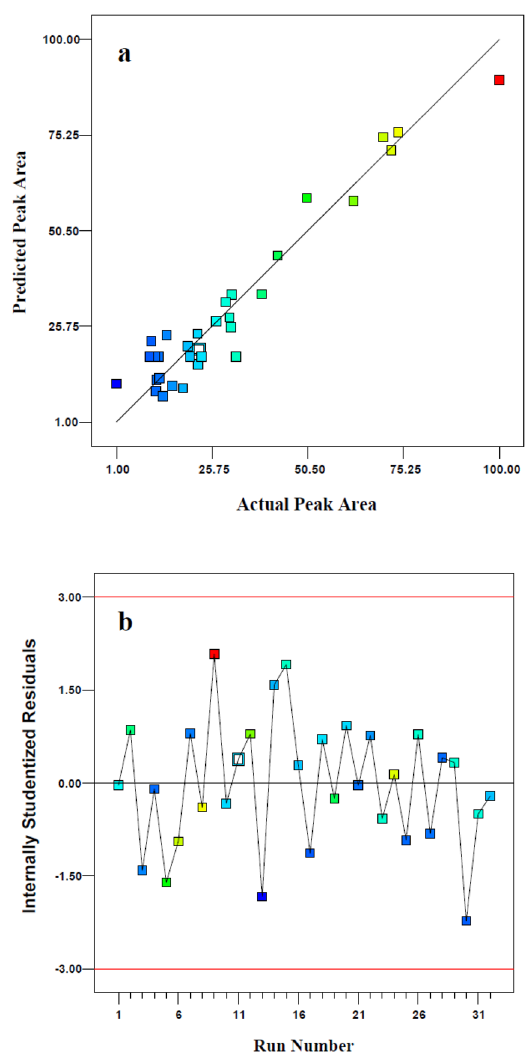
Figure 2. The internally studentized residuals vs. the performed runs ( a ); and the predicted value vs. actual response ( b